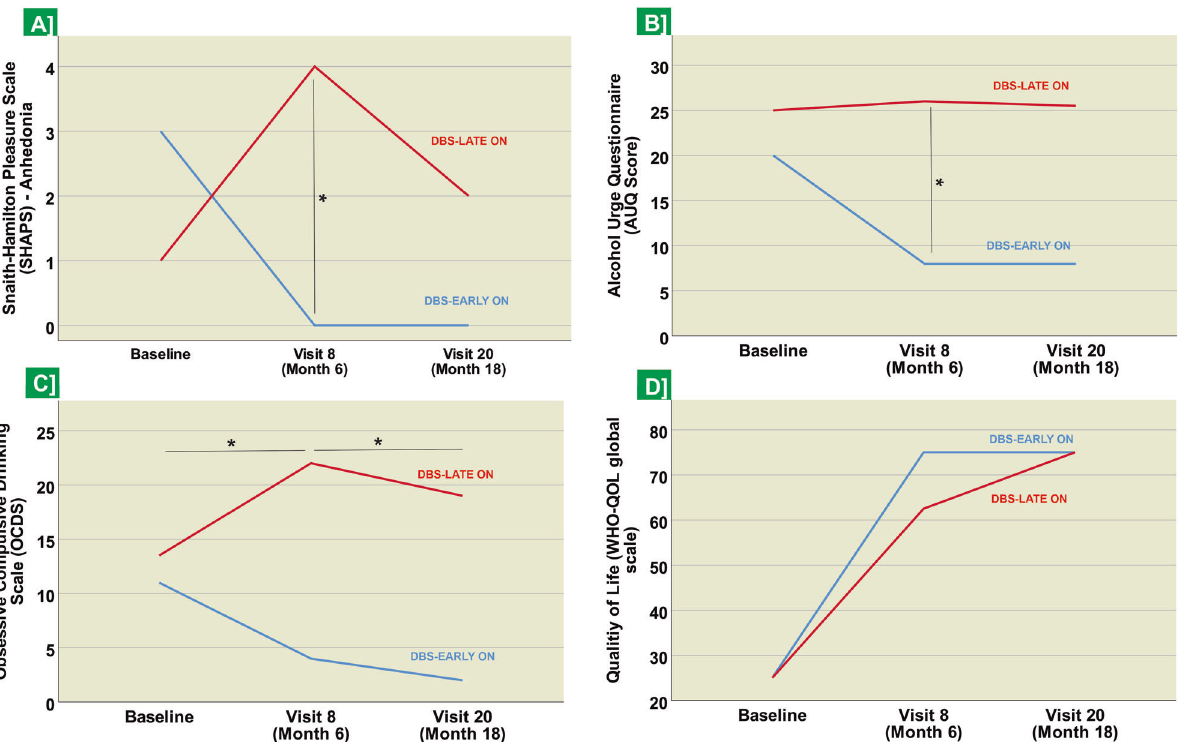
Fig. 5 Effects of NAc DBS on anhedonia, alcohol craving and quality of life. Depiction of median values and of signi fi cant longitudinal changes and group differences in A anhedonia (SHAPS), B , C alcohol craving (OCDS and AUQ), and D quality of life (WHOQOL-BREF) at baseline, at the 6-month visit (i.e., end of blinded phase), and at 18 months (after all patients had been actively stimulated for at least 12 months). *Signi fi cant differences between time points or study groups, as indicated, at p < 0.05, determined using Wilcoxon tests and Mann – Whitney U